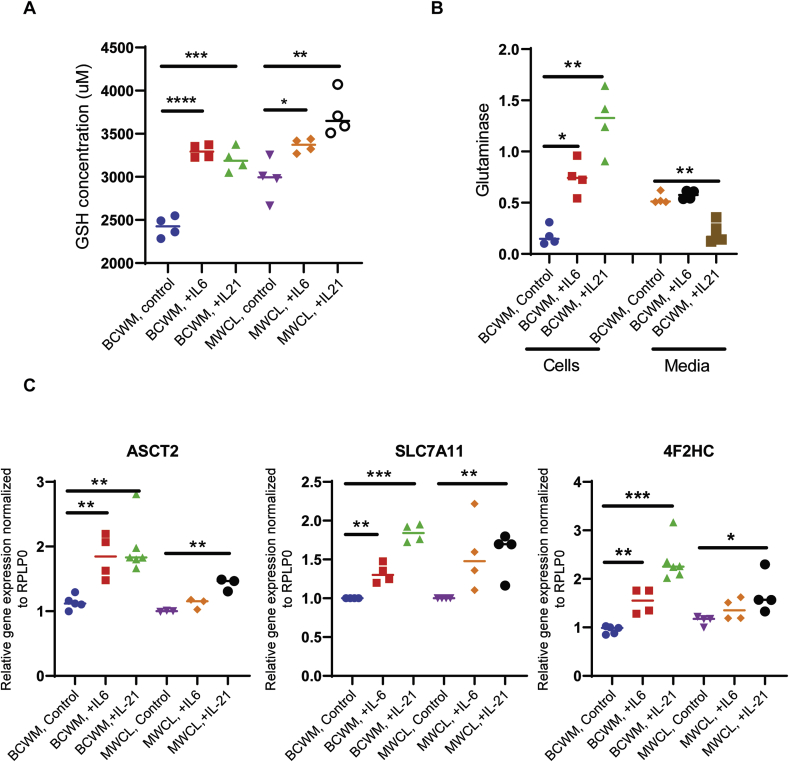
The effect of IL-6 and IL-21 on glutathione metabolism in WM. A) Bar graphs show the reduced glutathione (GSH) level is significantly elevated in the WM cell lines treated with IL-6 or IL-21 (*p = 0.01, **p = 0.005, ***p = 0.0002 and ****p < 0.0001). The data are from four separate experiments. B) Bar graphs showing the level of glutaminase in the cell lysates as well as cell culture media of BCWM.1 cells (*p < 0.04, **p < 0.01). C) RT-PCR analysis demonstrate the effect of IL-6 or IL-21 on the gene expression of ASCT2 (glutamine transporter), SLC7A11 and 4F2HC (components of cystine/glutamate antiporter on the cell membrane) in WM cell lines (*p < 0.05, **p < 0.01, ****p < 0.0001).